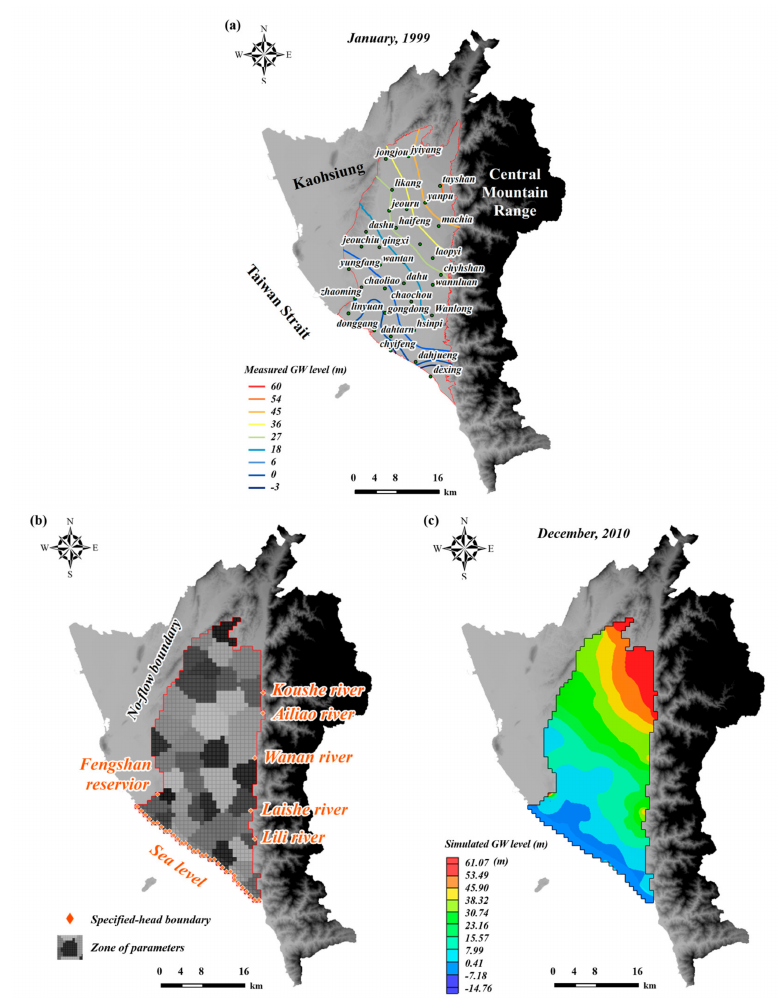
Figure 4. Regional groundwater flow model of Pingtung plain: ( a ) measured head in January, 1999; ( b ) grid cells and zones of parameters (hydraulic conductivity, specific storage, and specific yield); and ( c ) simulated groundwater levels in December